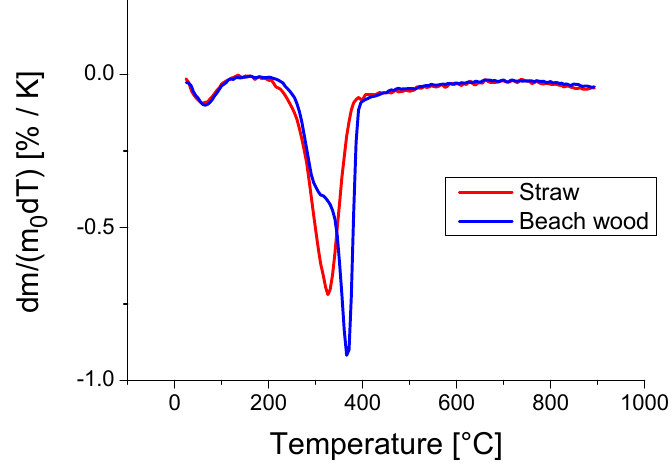
Figure 4. DTG of straw and beach wood chips, modified from [21].